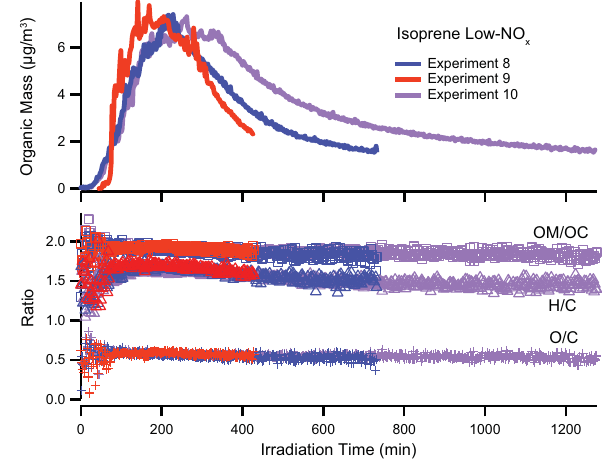
Fig.4. BottomPanel: AMSorganicmassloading (notcorrectedfor Fig. 4. Bottom Panel: AMS organic mass loading (not corrected for collection efficiency) for isoprene low- NO x experiments. Bottom collection efficiency) for isoprene low-NO x experiments. Bottom Panel: O/C, H/Cand OM/OC ratios of isoprene SOA formed under low- NO x conditions. Experiment 8 is in blue, 9 in red, and 10 in Panel: O/C, H/C and OM/OC ratios of isoprene SOA formed under purple. low-NO x conditions. Experiment 8 is in blue, 9 in red, and 10 in